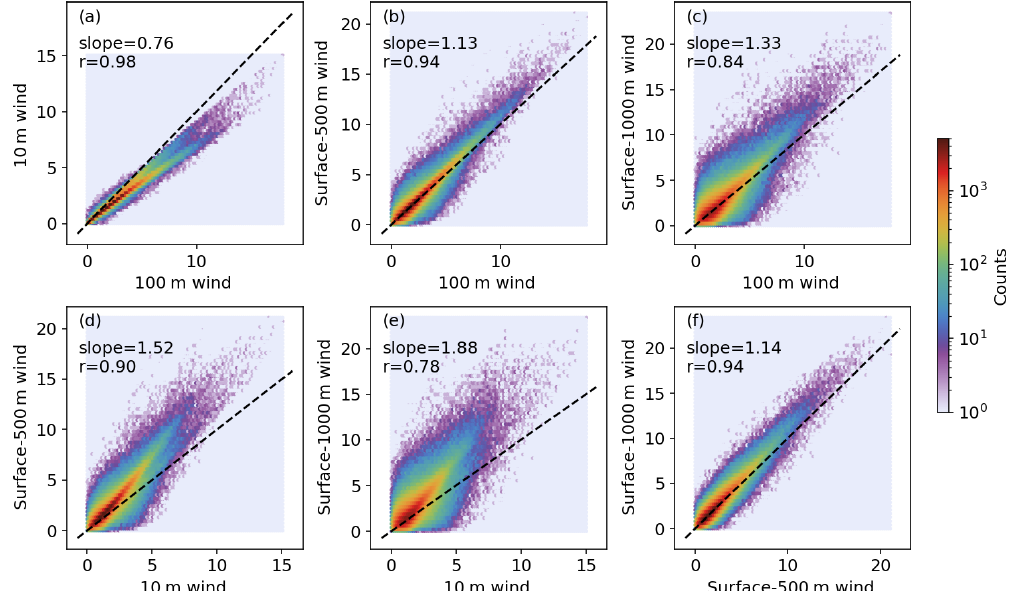
Figure 2. Correlations between speeds of 100m wind and 10m wind (a) , 100m wind and surface–500m wind (b) , 100m wind and surface– 1000m wind (c) , 10m wind and surface–500m wind (d) , 10m wind and surface–1000m wind (e) , and surface–500m wind and surface– 1000m wind (f) . Wind data are from ERA5 meteorology sampled at valid OMI NO 2 observation locations in the Po Valley air basin in 2004–2021. The slopes labeled in the plot are from orthogonal regression, and r is the correlation coefficient (wind speed unit: ms − 1 ).